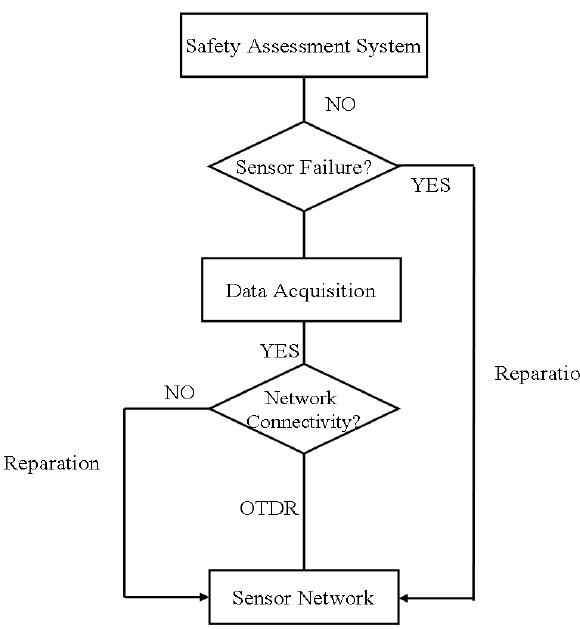
Figure 19. Repair strategy of self-healing